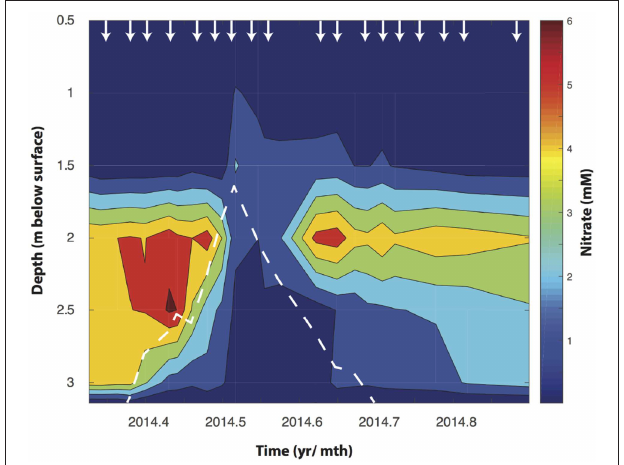
FIGURE 1 | Depth resolved NO 3 − concentrations changes in the Rifle floodplain well (TT-03) during an annual rise watertable depth (shown by the dotted white line). The arrows indicate the time points at which water samples were collected from each depth.